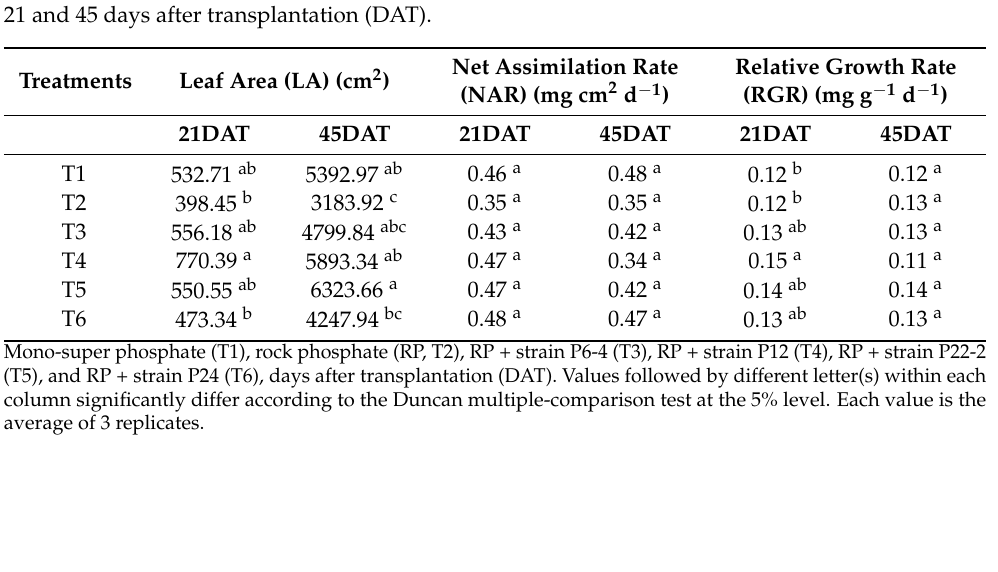
Mono-super phosphate (MSP, T1), rock phosphate (RP, T2), RP + strain P6-4 (T3), RP + strain P12 (T4), RP + strain P22-2 (T5) and RP + strain P24 (T6), dry matter (DM), days after transplantation (DAT). Values followed by different letter(s) within each column significantly differ according to the Duncan multiple-comparison test at the 5% level. Each value is the average of 3 replicates. The data related to the relative growth rate (mg g − 1 day − 1 ), net assimilation rate (mg cm 2 d − 1 ), and leaf area are presented in Table 2. The T4 treatment (RP + P12) and T5 (RP + P22-2) presented the highest and significant positive leaf area (770.39 and 6323.66 cm 2 ) for